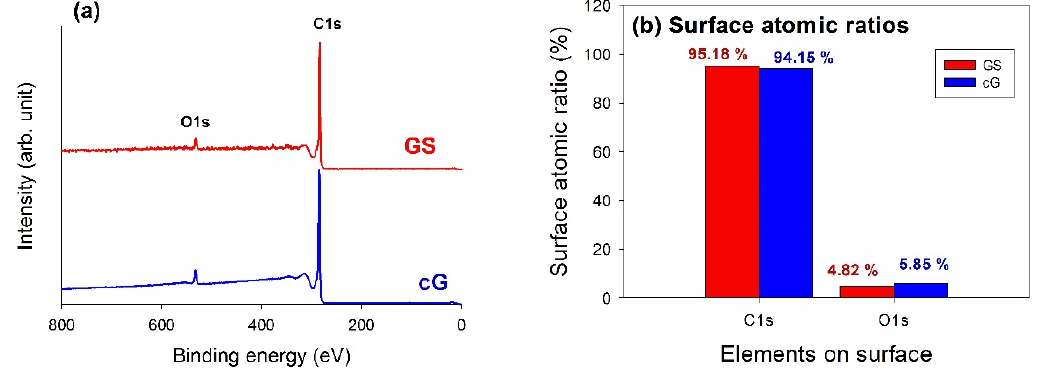
Figure 5. Figure 5. Cont. Figure 5. Cont.